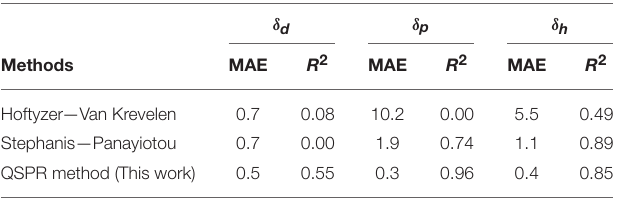
TABLE 3 | Coefficients of the linear regression for HSP prediction. Functional Group